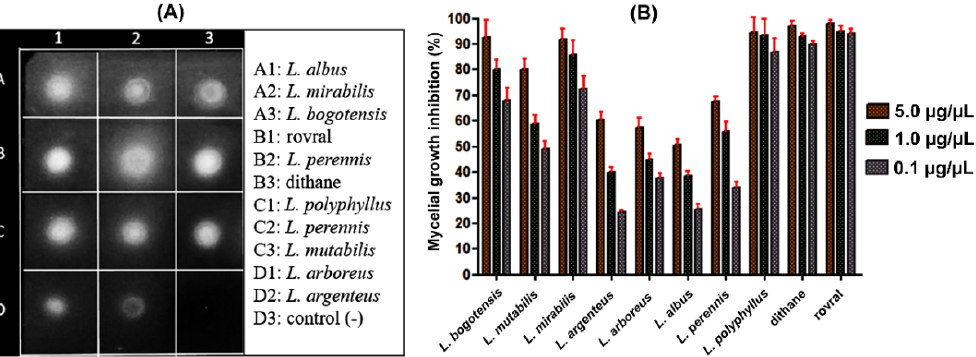
Figure 2. Antifungal activity against F. oxysporum QREs from eight lupin species. ( A ) Bioautography results using 50 µg of QREs; ( B ) Mycelial growth inhibition percentages of eight QREs at three concentrations.